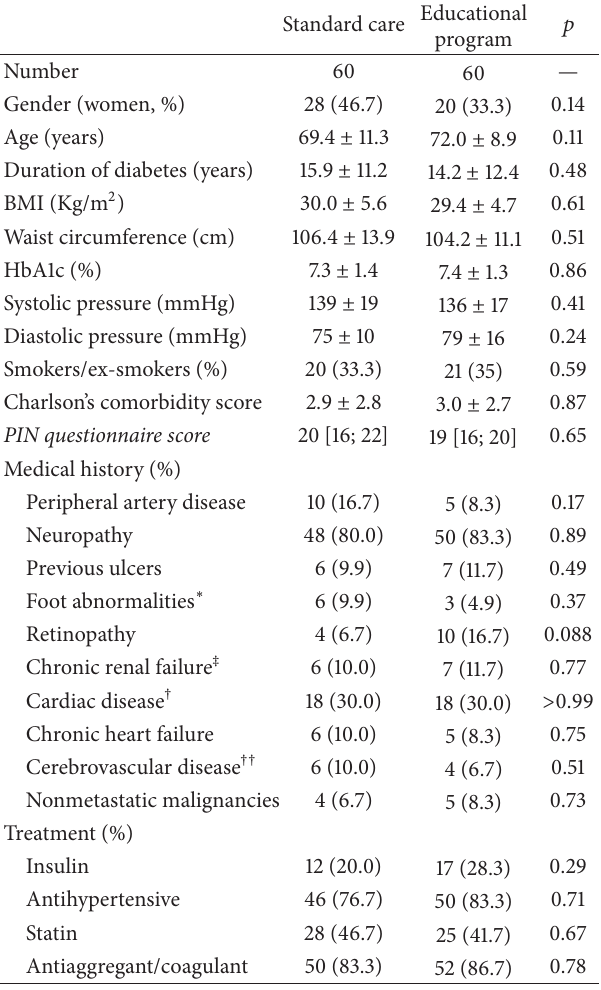
Table 1: Baseline demographic and clinical characteristics of the patients